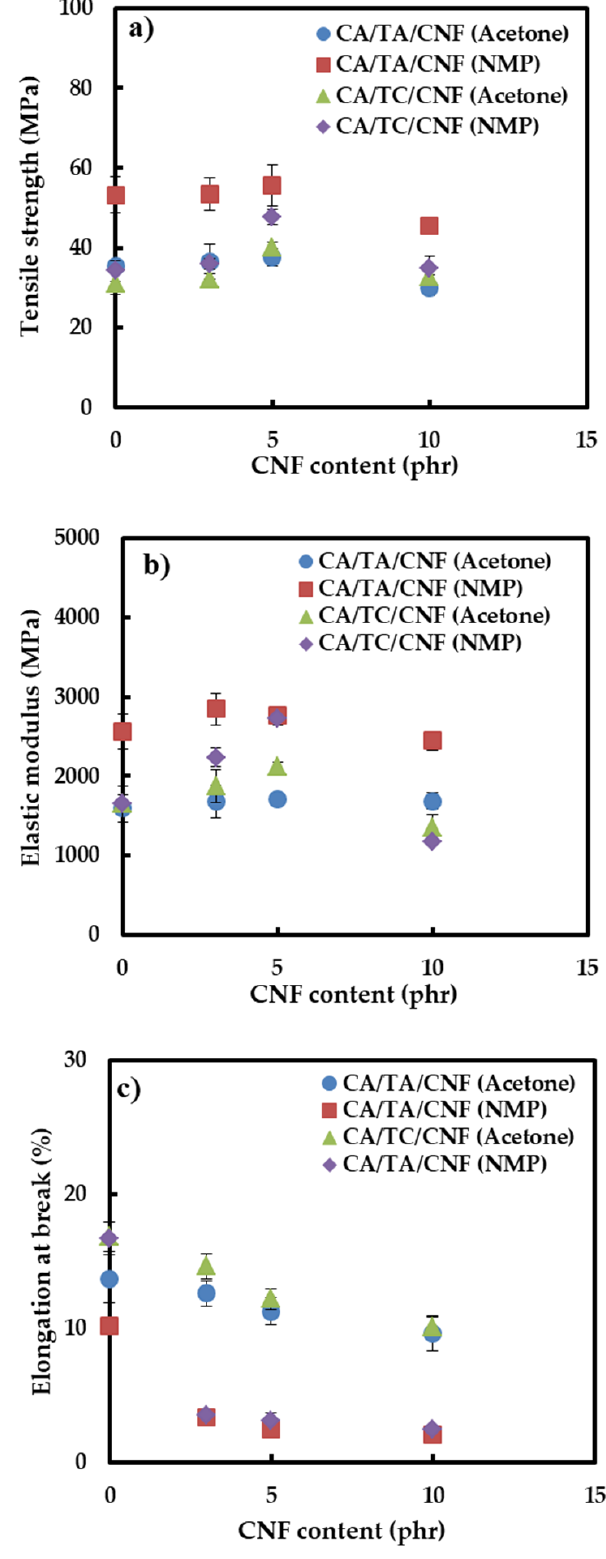
Figure 3. Digital photographs of plasticized CA/CNF films prepared in acetone ( a ) and NMP ( b ).